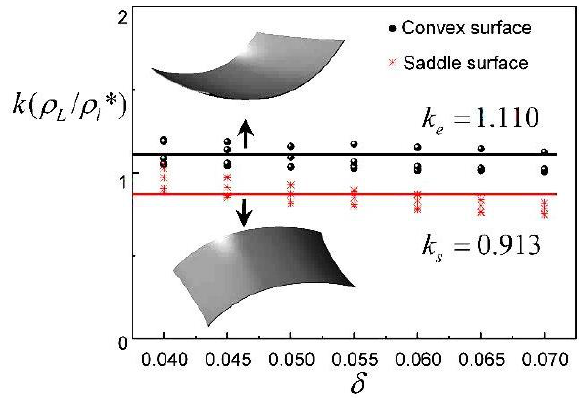
Figure 5. Ratio of simulation values to uncorrected calculated values.